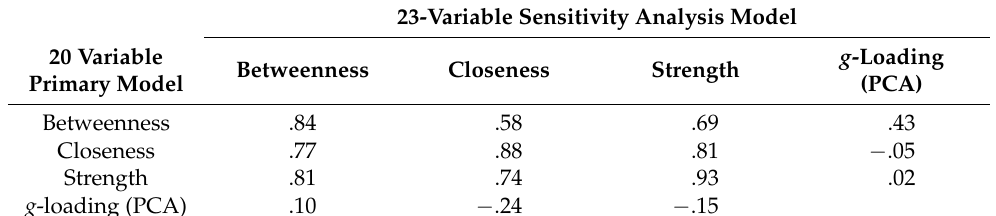
Table 3. Correlations between PNA-relative centrality metrics and psychometric g -loading informa- tion for 20 primary measures in 20- and 23-measure primary and secondary analysis models.